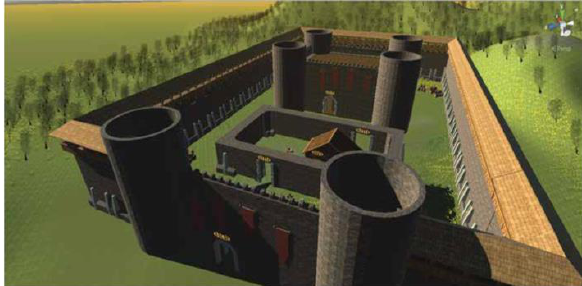
Figure 9: The whole Easy HTML kingdom.